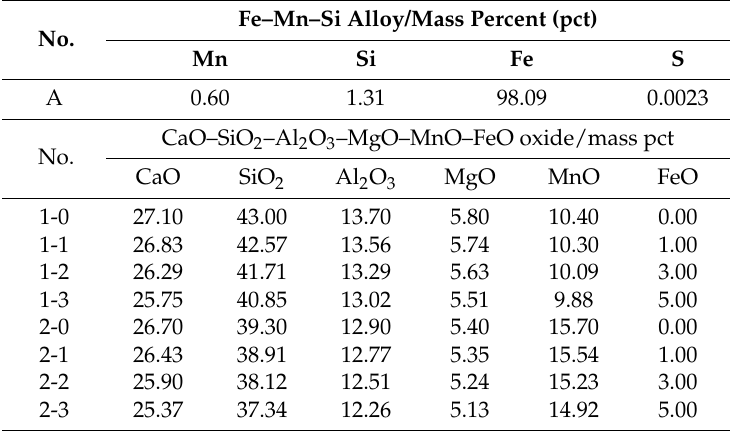
Table 1. Initial compositions of the Fe–Mn–Si alloy and CaO–SiO 2 –Al 2 O 3 –MgO–MnO–FeO oxides used to create the diffusion couples.